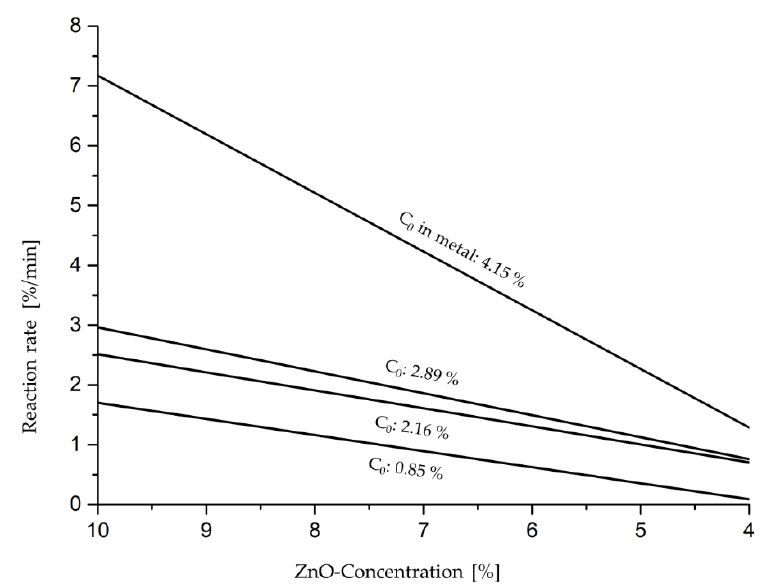
Figure 4. Comparison of reaction rates over the concentration range of 10% to 4%.